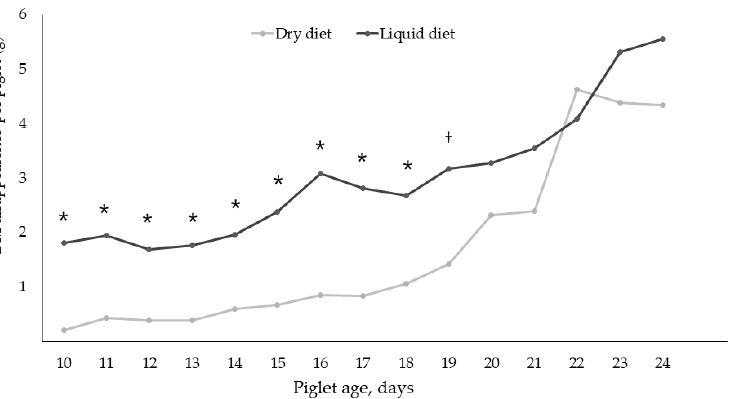
Figure 1. The average daily dry matter (DM) disappearance per piglet in litters fed either dry (DCF) or liquid creep feed (LCF) from day 10–24 postpartum. * Statistical significance between dietary treatments ( p < 0.05) and † statistical tendency between dietary treatments ( p < 0.1).